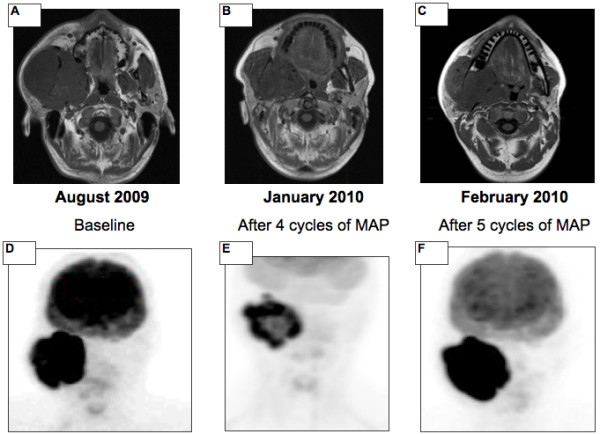
The value of 18FDG PET/CT value in determining the management of a patient with craniofacial bone sarcoma. The initial response to treatment, after four cycles of MAP chemotherapy, is documented by both MRI (A versus B) and 18FDG PET/CT (D versus E). At the subsequent restaging, performed early due to worsening pain, the MRI scan (C) continued to demonstrate stable disease while the 18FDG PET/CT demonstrated overt disease progression with an increase in SUV from 21 to 42 (F).